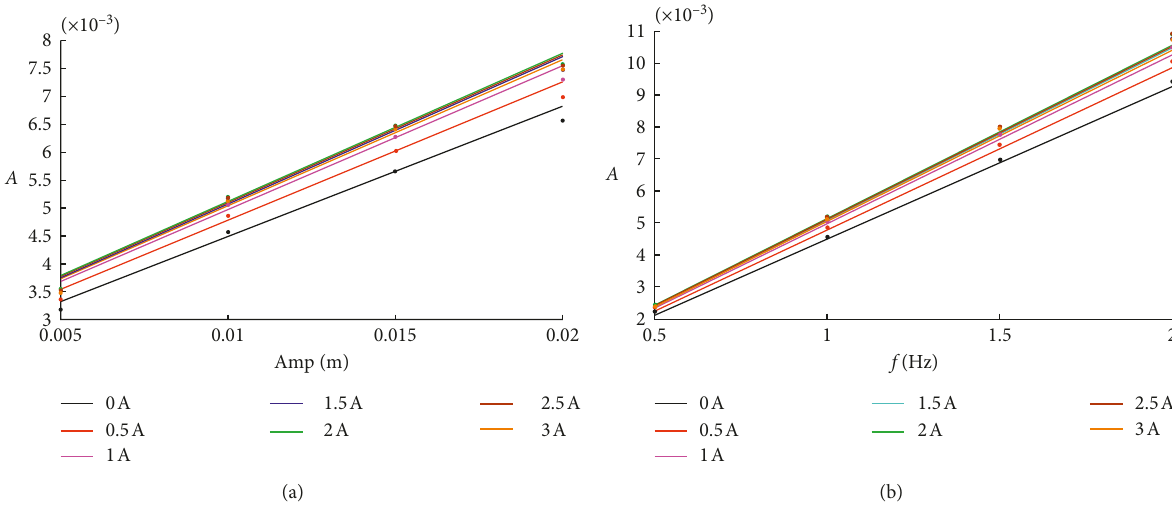
Figure 8: The fitting map of Parameter A and amplitude and frequency. The points represent the experimental values, and the line represents the fitted value. (a) Parameter A and amplitude fit graph. (b) Parameter A and frequency fit